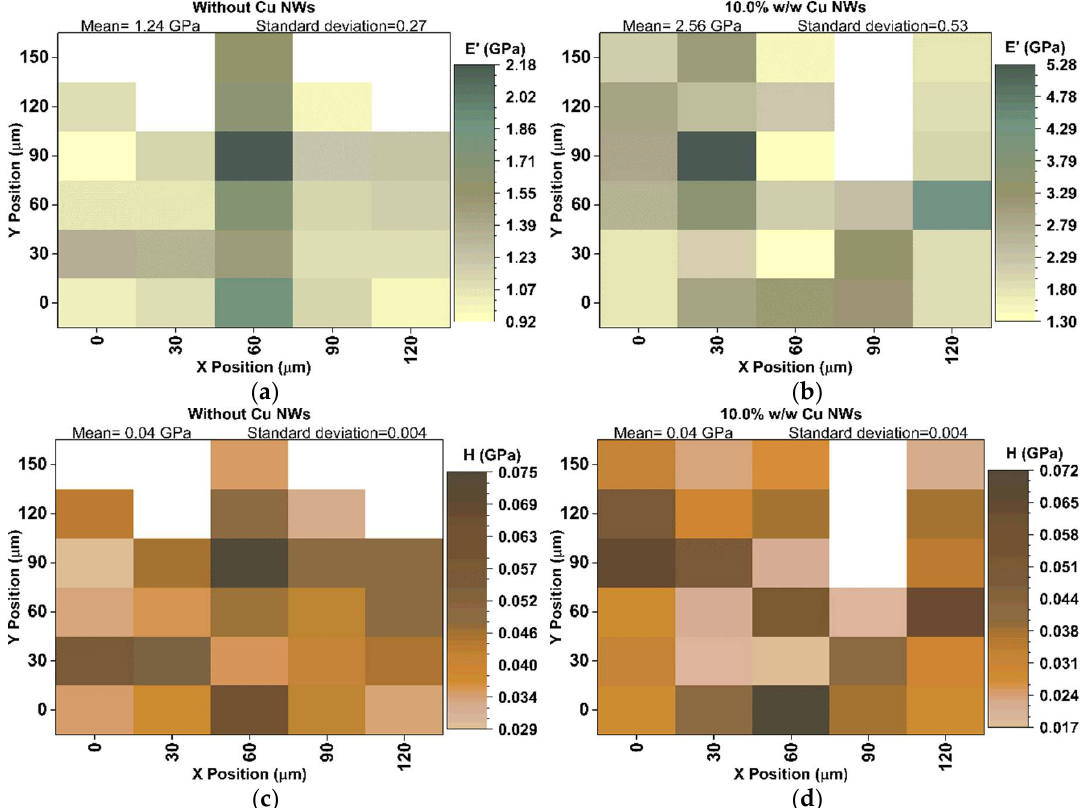
Figure 7. Contour maps of mechanical properties variation in the measurements of E (cid:48) ( a , b ) and H ( c , d ), obtained on a surface area of 120 μm × 150 μm in the substrates manufactured of resin without Cu NWs ( a , c ) and with Cu NWs at 10.0% w / w ( b , d ),